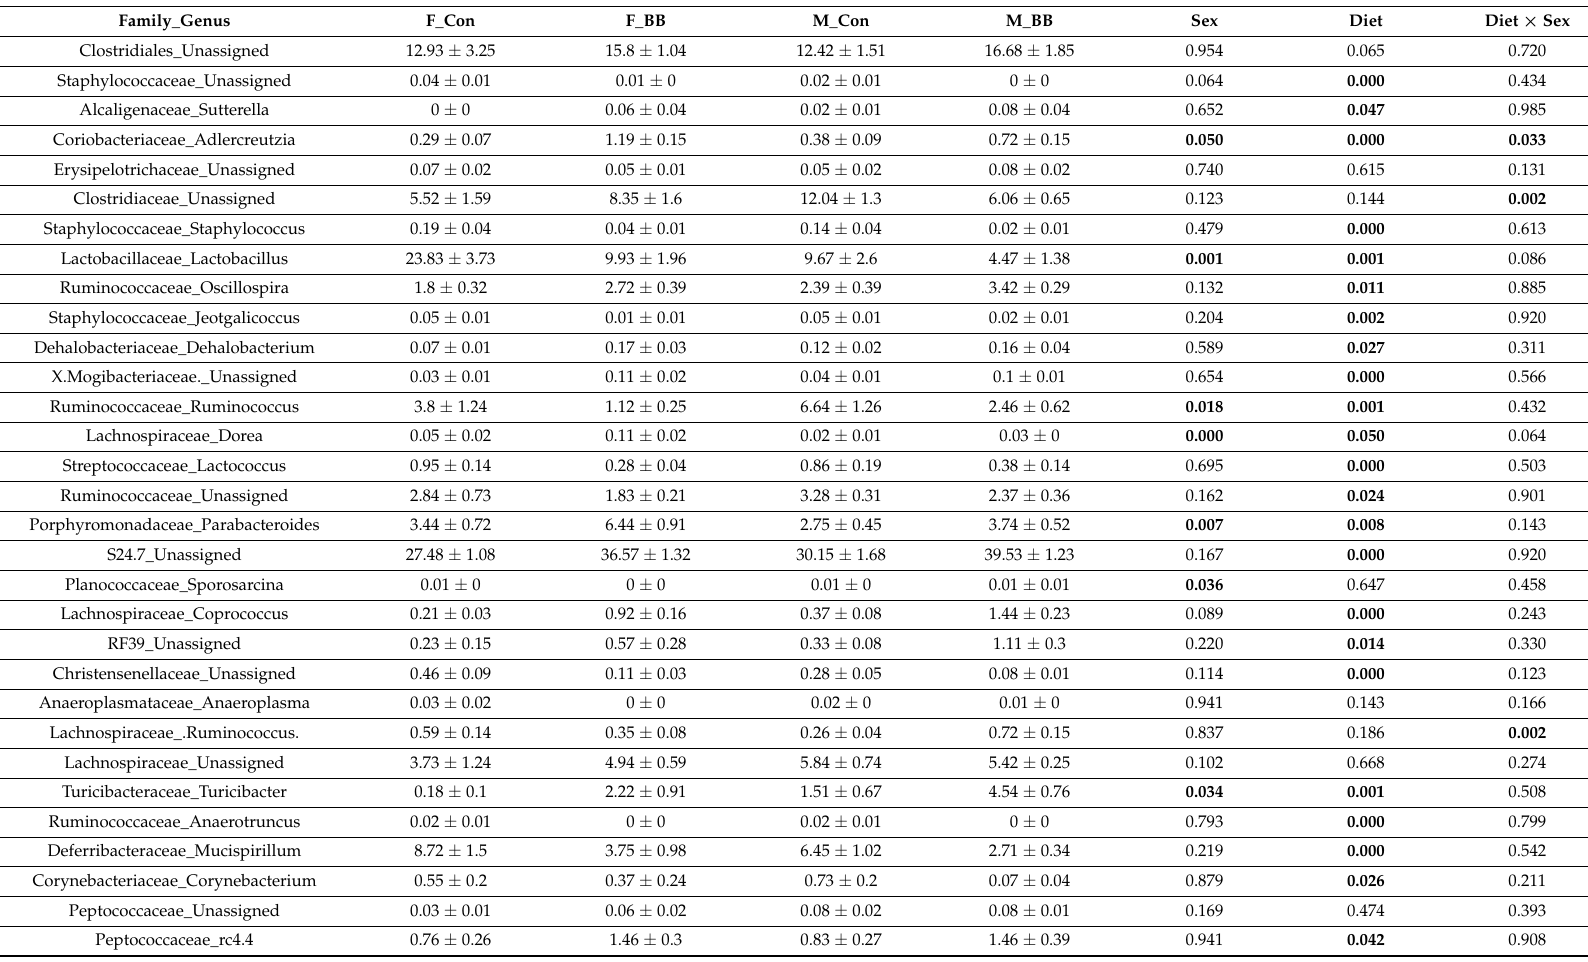
Table 3. The operational taxonomical unit (OTU) abundance at the genus level. F-BB (female mice fed a blueberry diet) ( n = 9), F-Con (female mice fed a control diet) ( n = 7), M-BB (male mice fed a blueberry diet) ( n = 9), and M-Con (male mice fed a control diet) ( n = 9). Data are expressed as mean ± SE. Statistical differences between the groups were determined by Two-Way ANOVA for sex, diet, and their interaction. Bold typed numbers indicate the significantly different